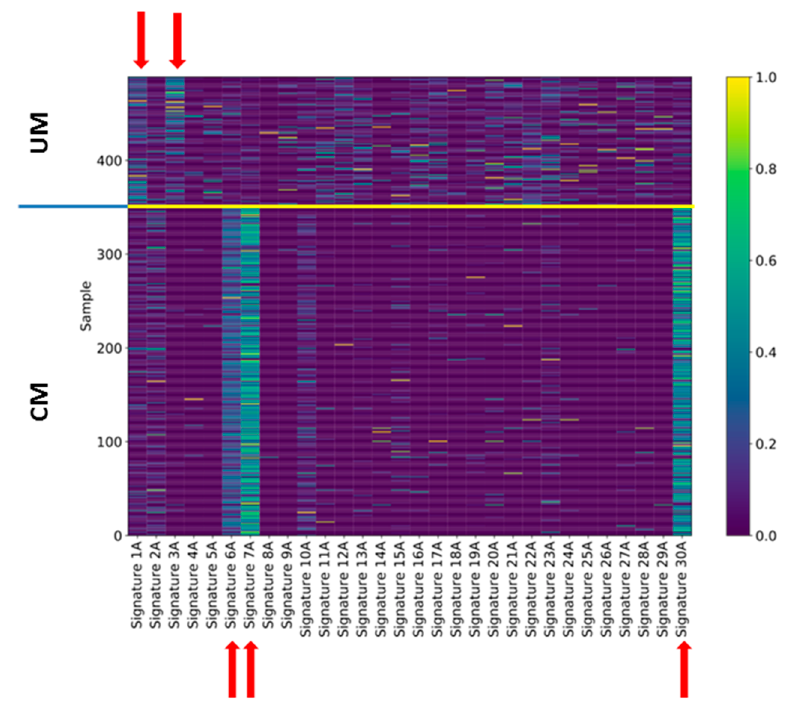
Figure 4. Exposures of uveal and cutaneous melanoma to Alexandrov’s signatures. The exposure of each single case of uveal (upper part) and cutaneous (lower part) melanoma to Alexandrov’s signatures was indicated by a color code (0 = completely absent, 1 = perfect match). The signatures that show the main exposures are indicated by red arrows.